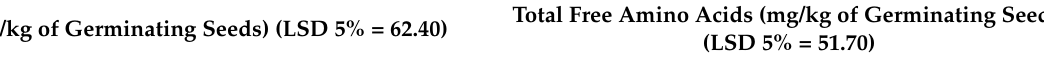
Oil Content (LSD 5% = 3.36) Free Fatty Acids (LSD 5% = 7.61)